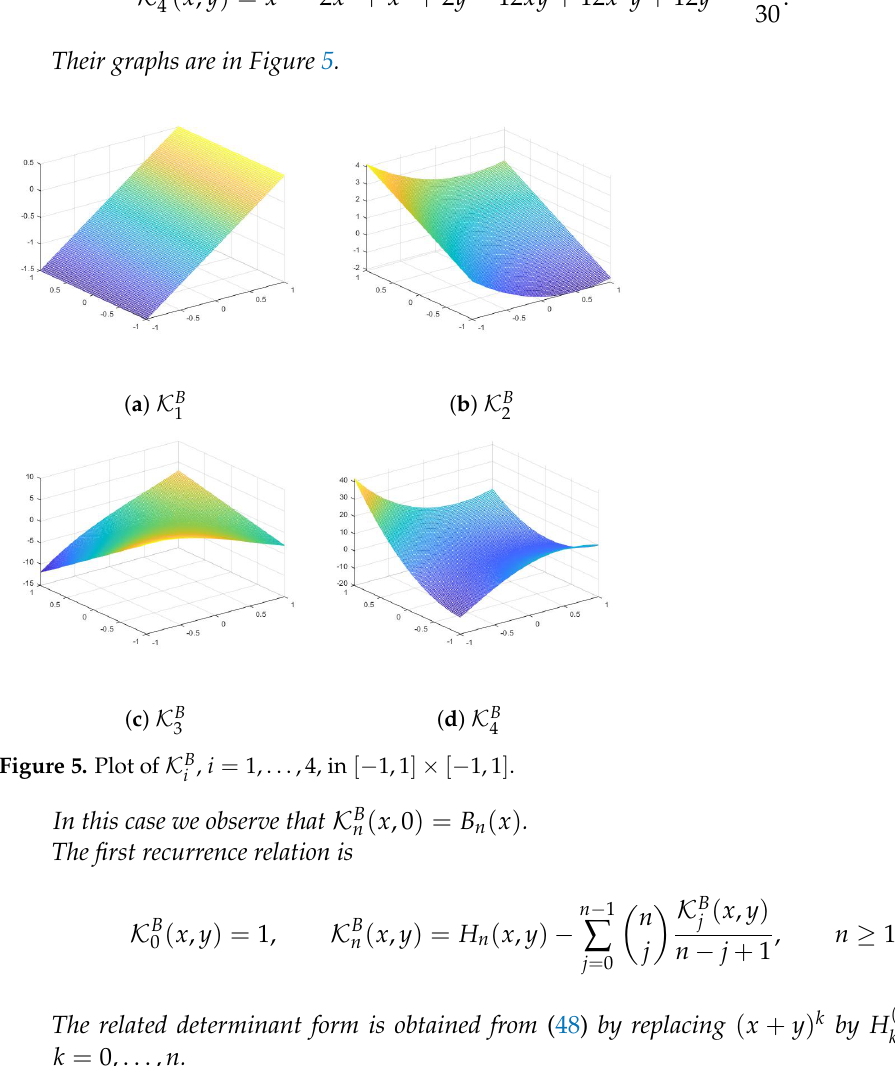
Figure 5. Plot of K B